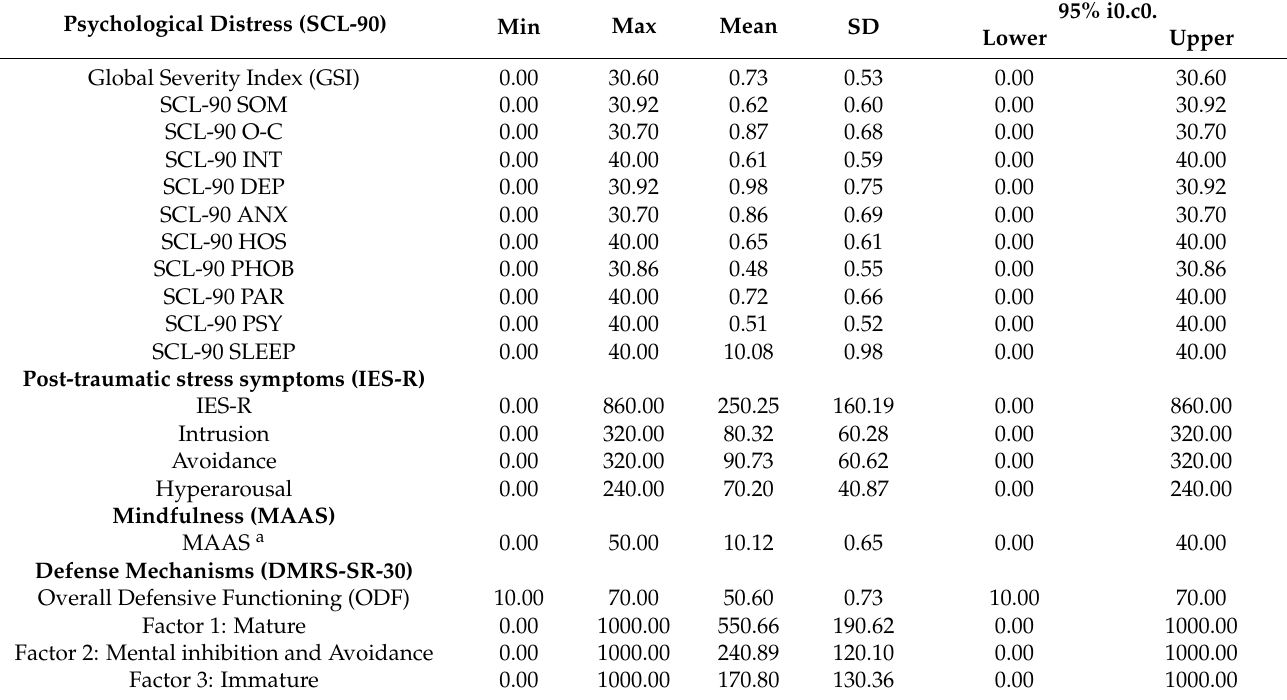
Table 1. Descriptive statistics of responders’ psychological characteristics (N =